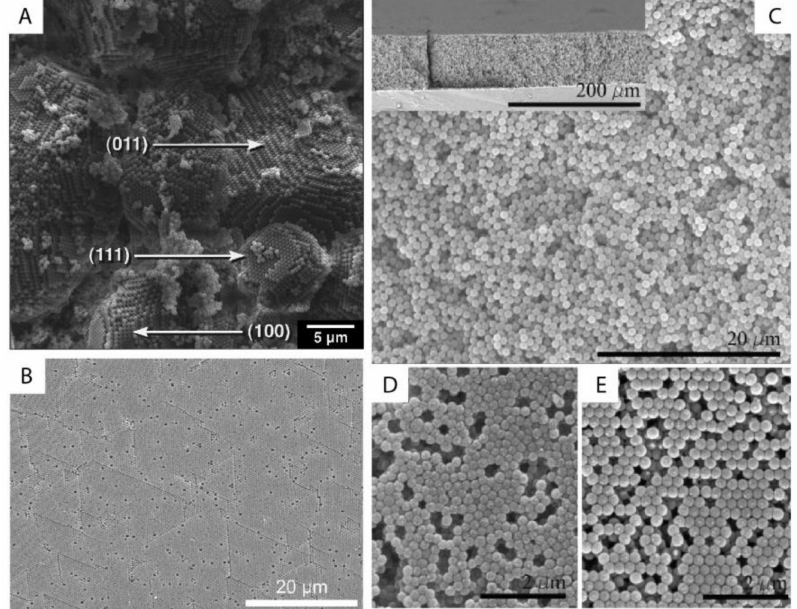
Figure 11. ( A ) SEM image of a small colloidal crystal of monodisperse latex nanoparticles after the centrifugation with (100), (111) and (011) faces being labelled; ( B ) SEM image of a crystalline film of monodisperse silica nanoparticles after the centrifugation experiment; ( C – E ) SEM image of a colloidal glass of latex nanoparticles after the centrifugation experiments. In ( C ), salt was added to break the stability of these particles and to introduce the coagulation for the disordered structure. In ( D , E ), a second type of nanoparticle was introduced first and then selectively etched for the disordered structure. Reproduced with permission from [133], Copyright the American Chemical Society, 1999, and [141], Copyright Wiley-VCH, 2007.